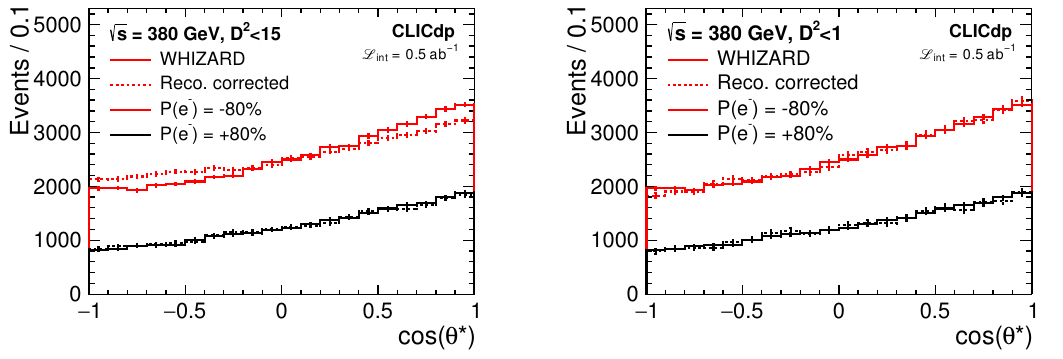
p Figure 16. The s 0 distribution for tt events at ISR, electroweak corrections, and the CLIC luminosity spectrum.